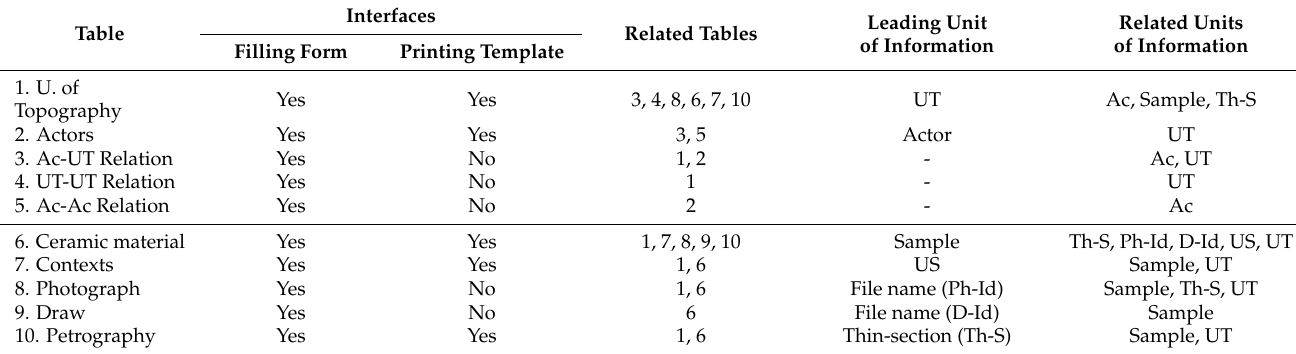
Table 2. Summary table of table relations and leading or related units of information, in accordance with the G REYWARE data model shown in Figure 6.